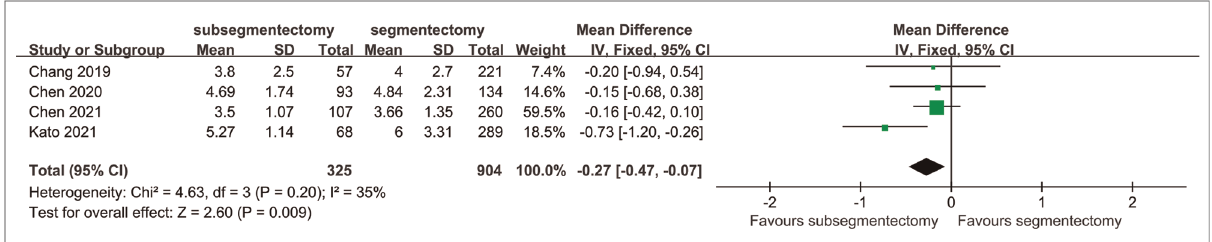
FIGURE 4 Forest plot: the postoperative hospital stay of subsegmentectomy vs. segmentectomy.